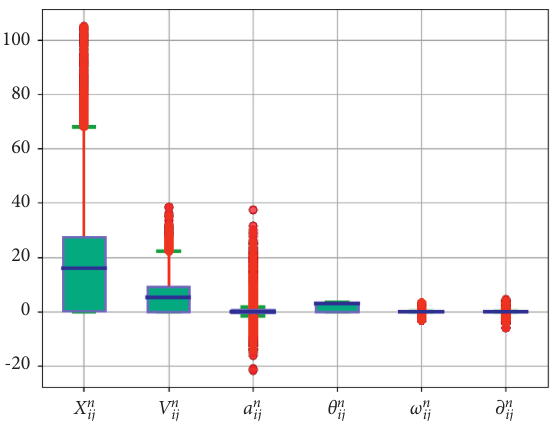
Figure 6: Box diagram of vehicle behavior in the closed straight